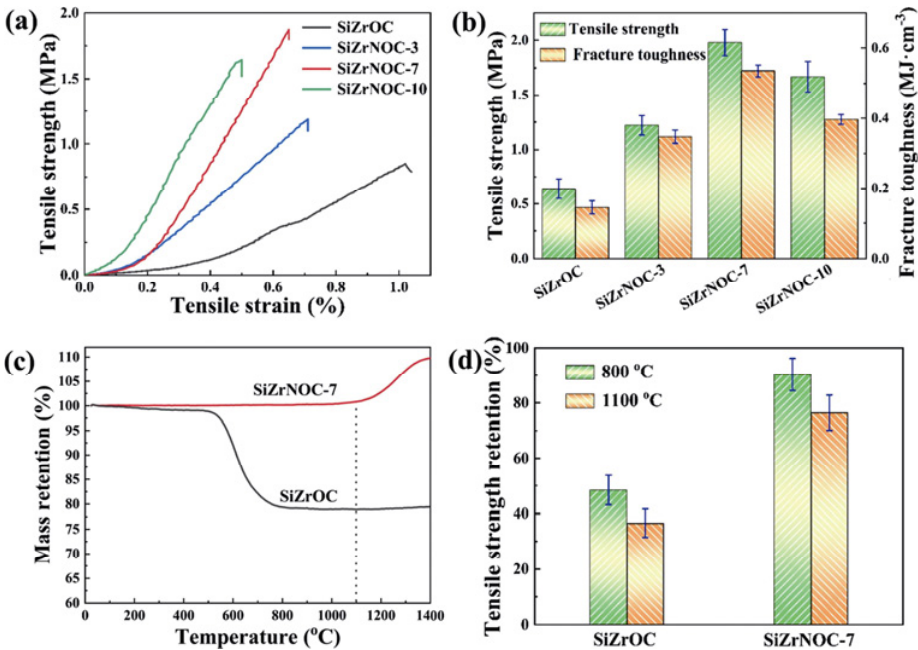
Fig. 5 (a) Tensile strength–strain curves, (b) tensile strength and fracture toughness, (c) TG curves in air, and (d) tensile strength retention after heat-treated at 800 and 1100 ℃ in air of SiZrOC and SiZrNOC-7